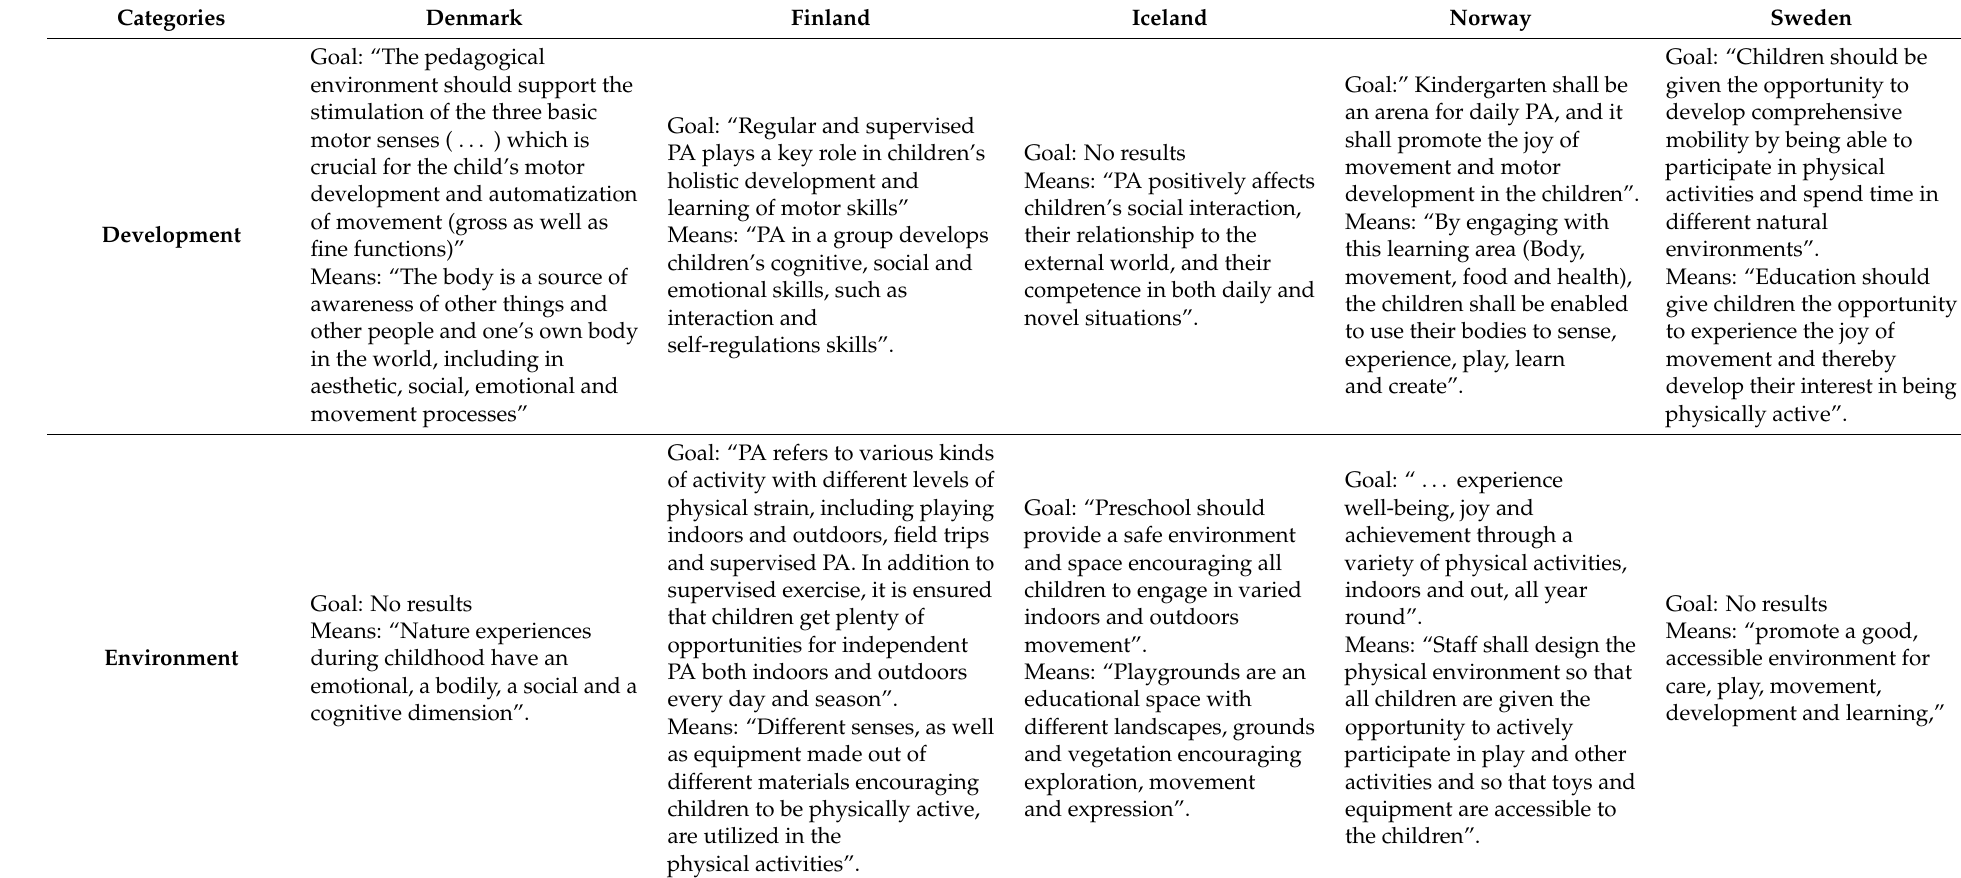
Table 3. Excerpts reflective of MoPA as a goal and means in the national curricula from Denmark (DK), Finland (FI), Iceland (IS), Norway (NO) and Sweden (SE) according to context